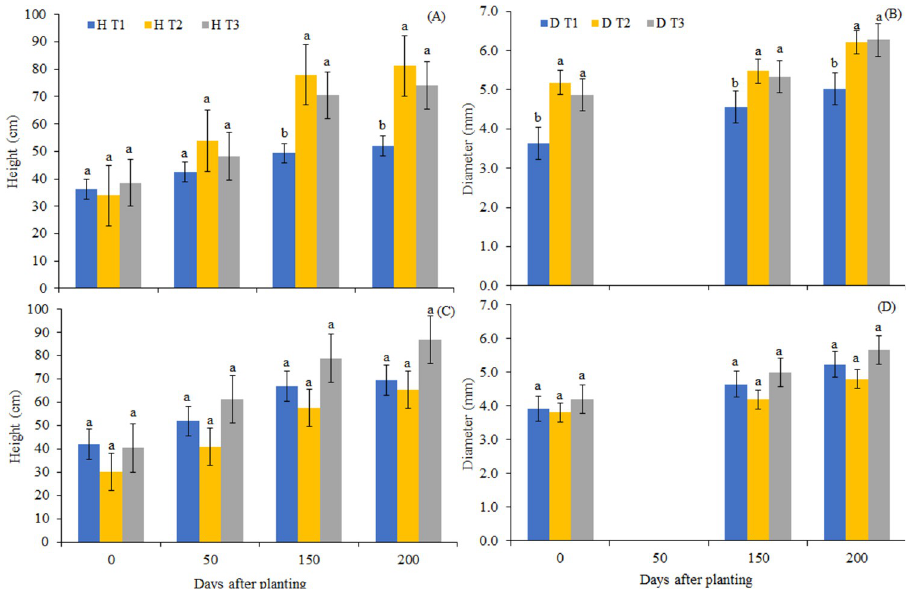
Fig 6. Growth in height and diameter of seedlings of D . nigra , planted in the forest restoration area of the Atlantic Forest, under C 1 (A and C) and C 2 (B and D) covers. C 1 : full sun; C 2 : 49.4% shading; T1: control water; T2: Ozonation for 1h; T3: Ozonation for 2h. Means followed in the column by the same letter do not differ from each other by Tukey’s test, at 5% probability; (n =